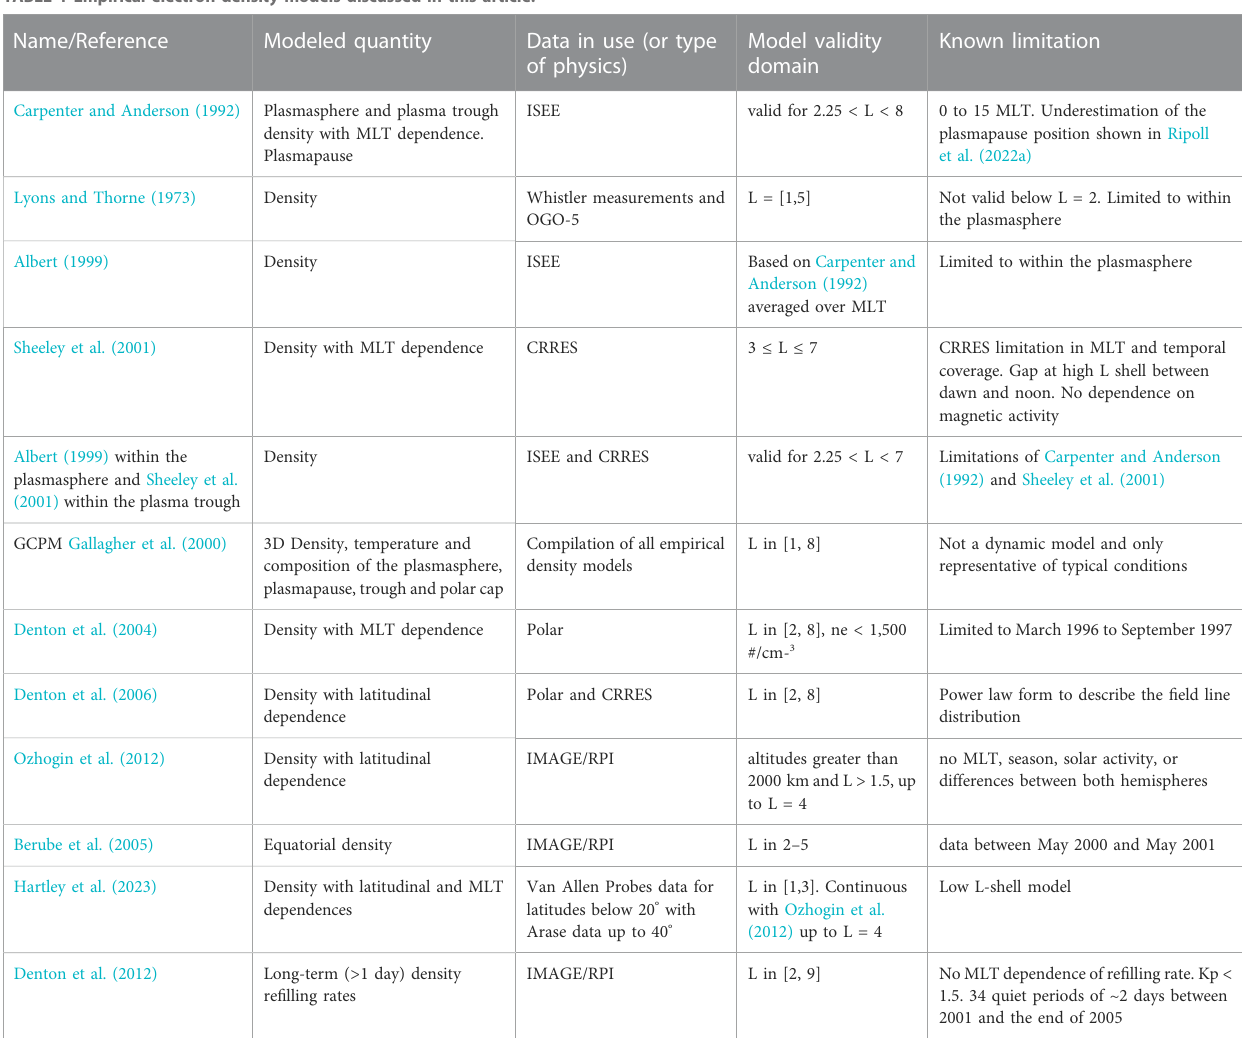
TABLE 1 Empirical electron density models discussed in this